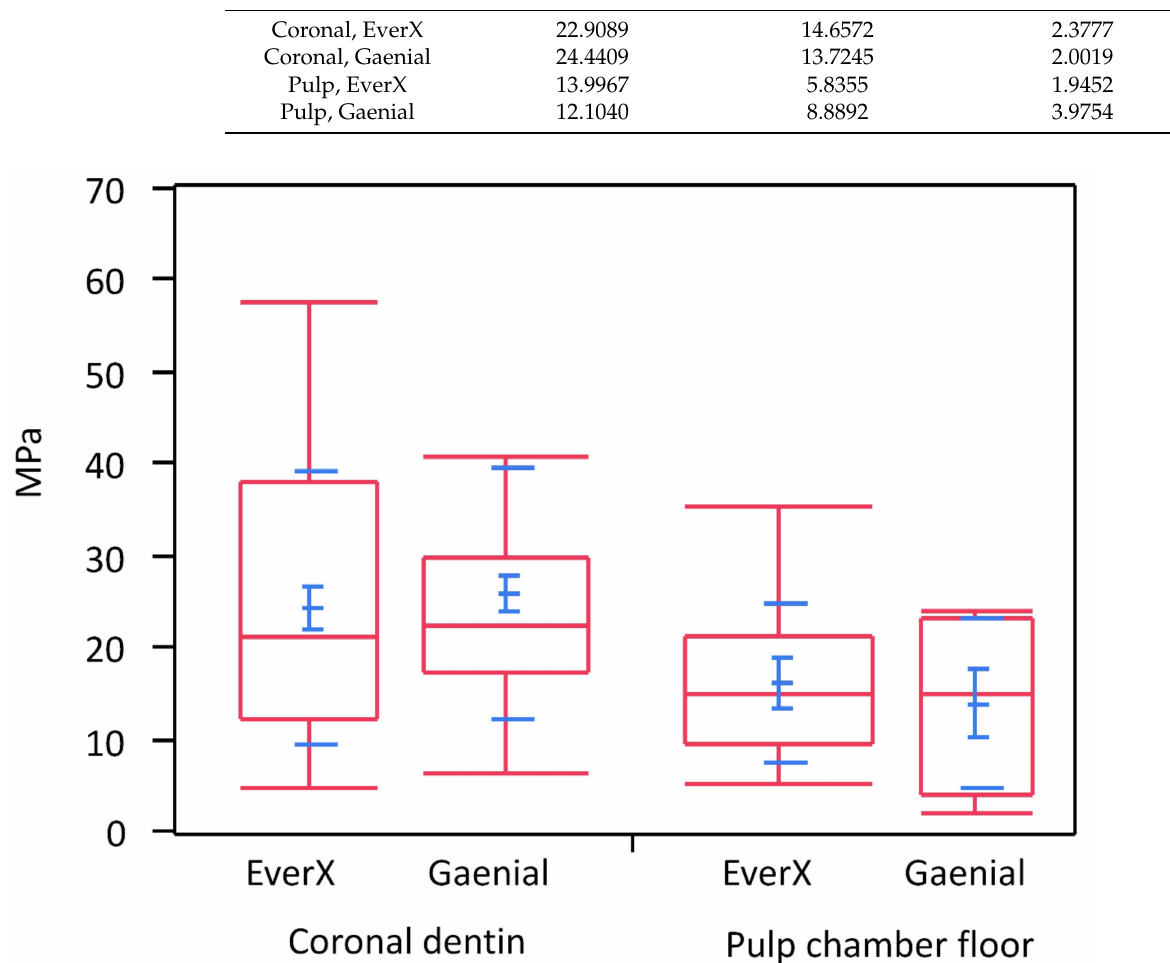
Figure 4. Box plot depicting the bond strength in MPa of the tested composite resin materials either bonded to coronal dentin or the dentin in proximity to the pulp chamber. The quartiles and 95% C.I. are depicted in red, while means +/ − 1 standard error and +/ − 1 standard deviation are shown in